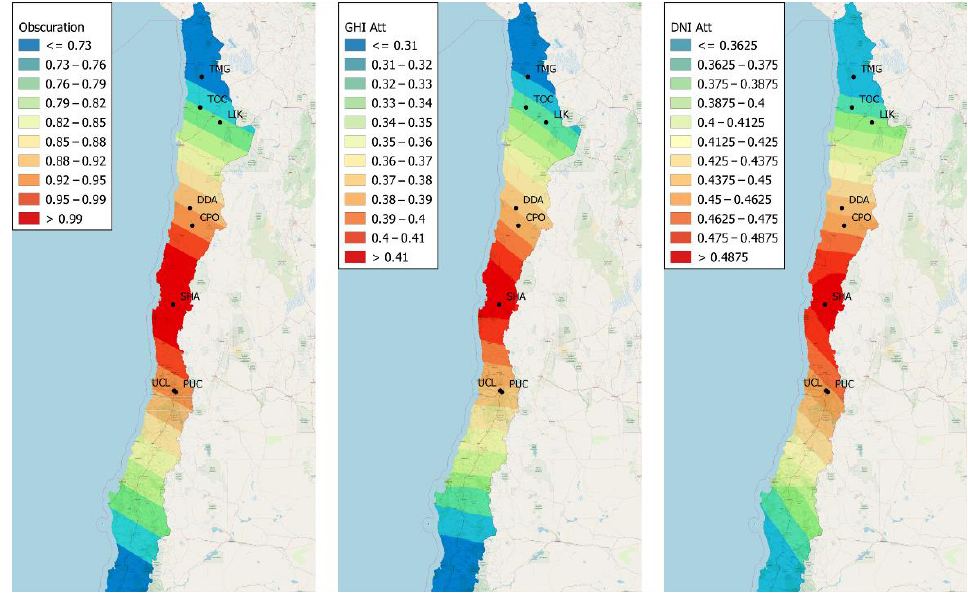
Figure 14. Maximum obscuration and estimated GHI and DNI attenuations for the Chilean territory during the 2 July 2019 solar eclipse.